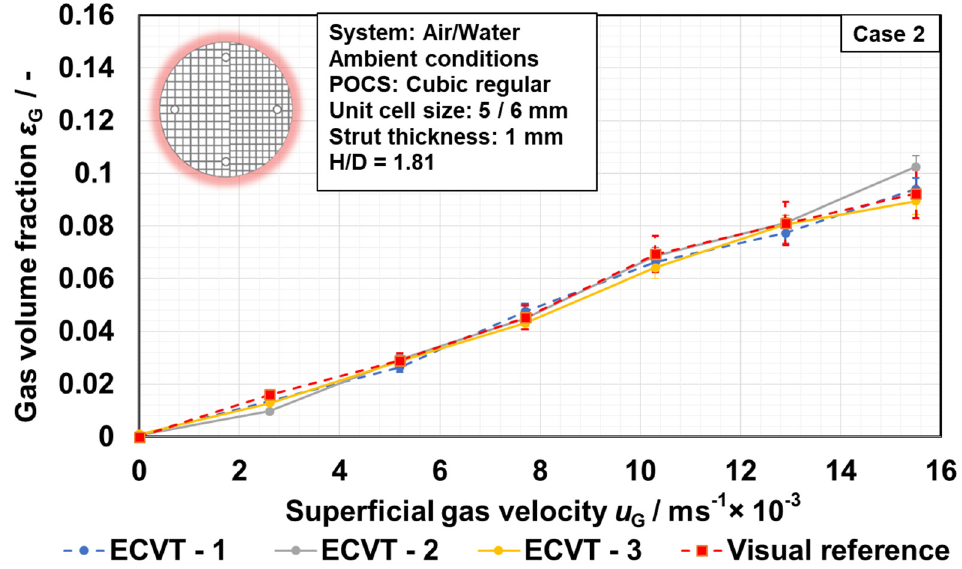
Figure 9. Overall gas holdup over superficial gas velocity for three ECVT measurement repetitions compared with the visual reference showing the reproducibility of the ECVT measurement technique.